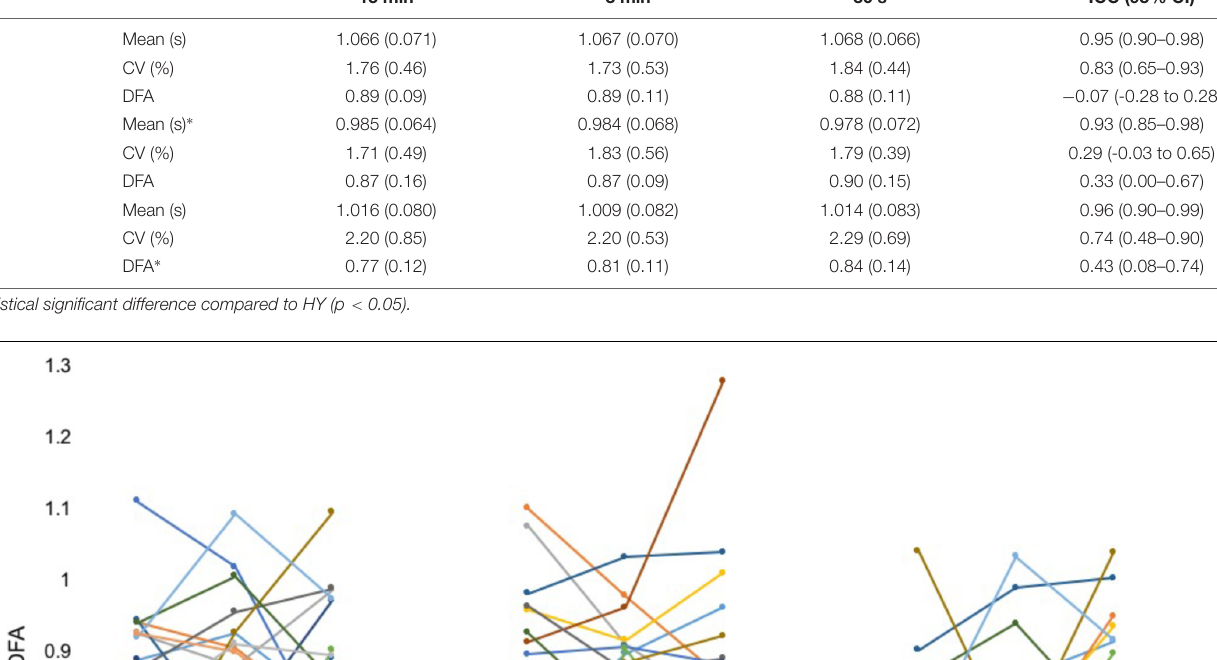
TABLE 2 | Mean (SD) of stride time series mean, standard deviation and DFA values, and corresponding intra-class correlation coefficients (95% confidence interval) for each group. 15 min